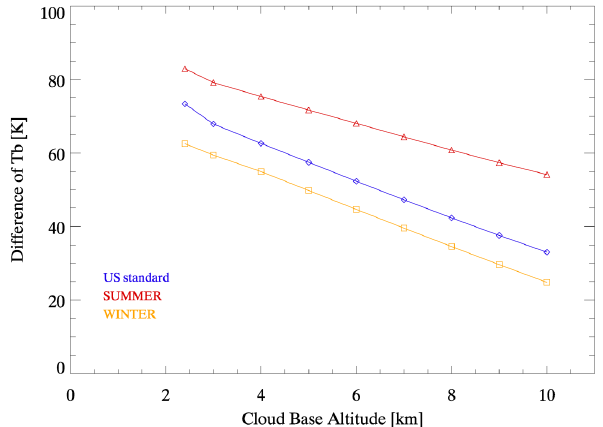
Figure 7. The simulated cloud effects to the downwelling radiance (brightness temperature difference between cloud and clear cases) as a function of the different cloud altitudes with different atmo- spheric profiles. Used cloud type is altocumulus given in Modtran 5.2 with the thickness of 600m. The high resolution spectral data are convolved with the spectral response function to give the band averaged contribution value and brightness